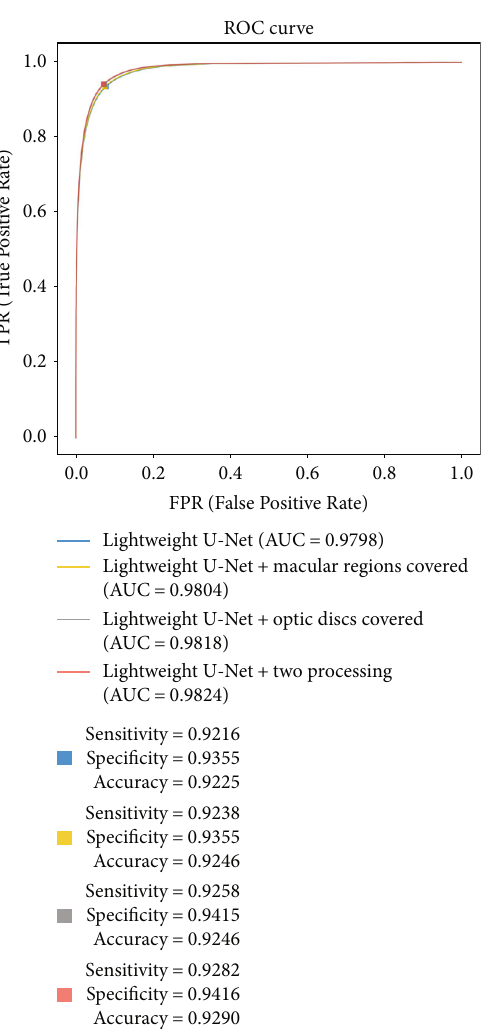
Figure 5: The ROC curves of the lightweight U-Net, the lightweight U-Net with either postprocessing procedure, and with both postprocessing procedures. The x -axis represented the false- positive rate, i.e., 1-speci fi city, and the y -axis represented the true-positive rate, i.e., sensitivity. The area under the curve (AUC) was also calculated, which was presented on the bottom right of the fi gure. The optimal pair of sensitivity and speci fi city chosen based on Youden ’ s index were also marked on the curve, and the precise numeric values were presented on the right